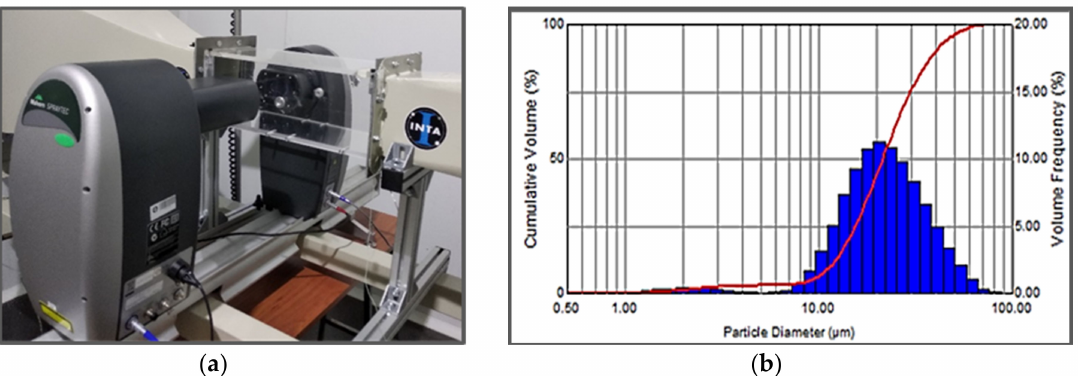
Figure 5. ( a ) Image of the Spraytec system attached to the icing wind tunnel (IWT) and the testing chamber. ( b ) Droplet size distribution of the testing